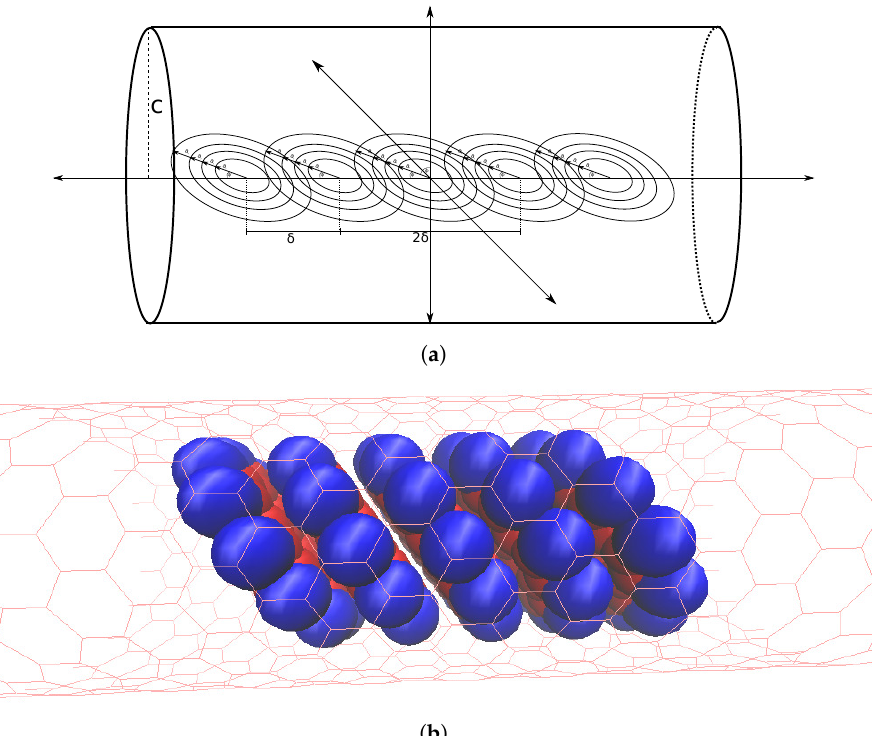
Figure 7. Stack of coronene molecules ( a ) approximated by concentric rings, all equidistant along central axis of nanotube, by distance δ and all tilted by same angle φ and ( b ) represented by space filling model.